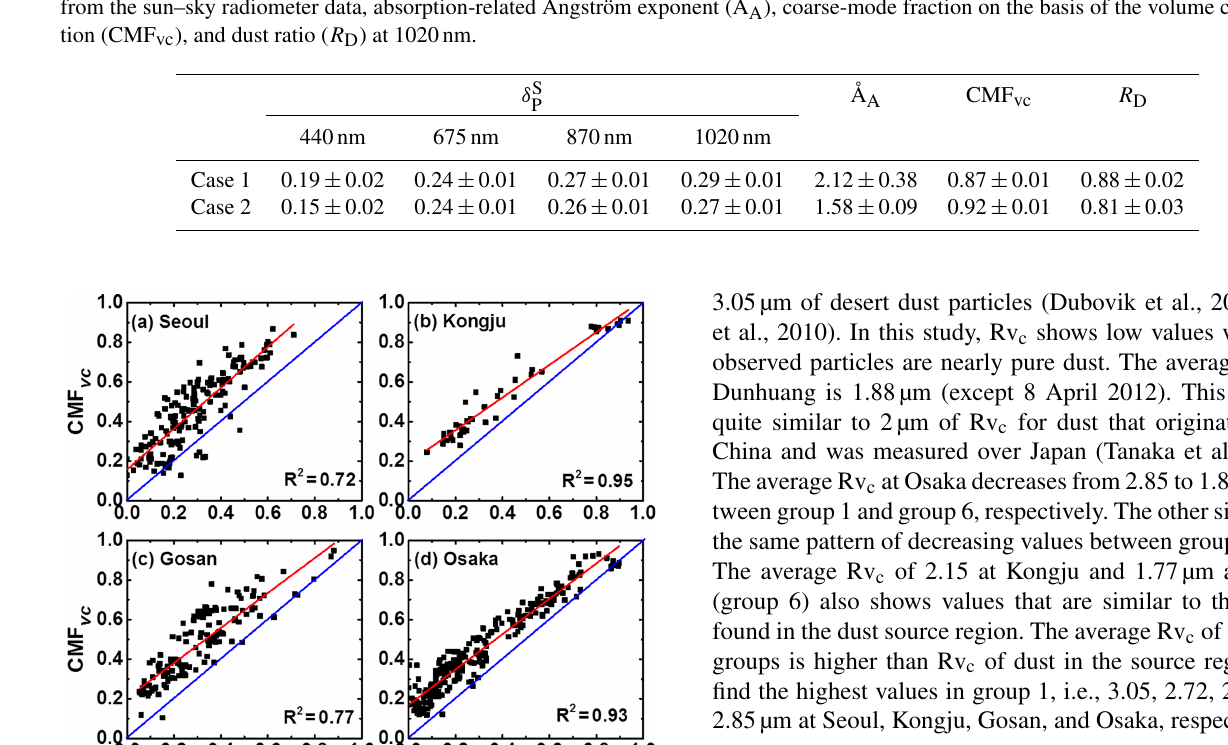
) at 440, 675, 870, and 1020nm derived P